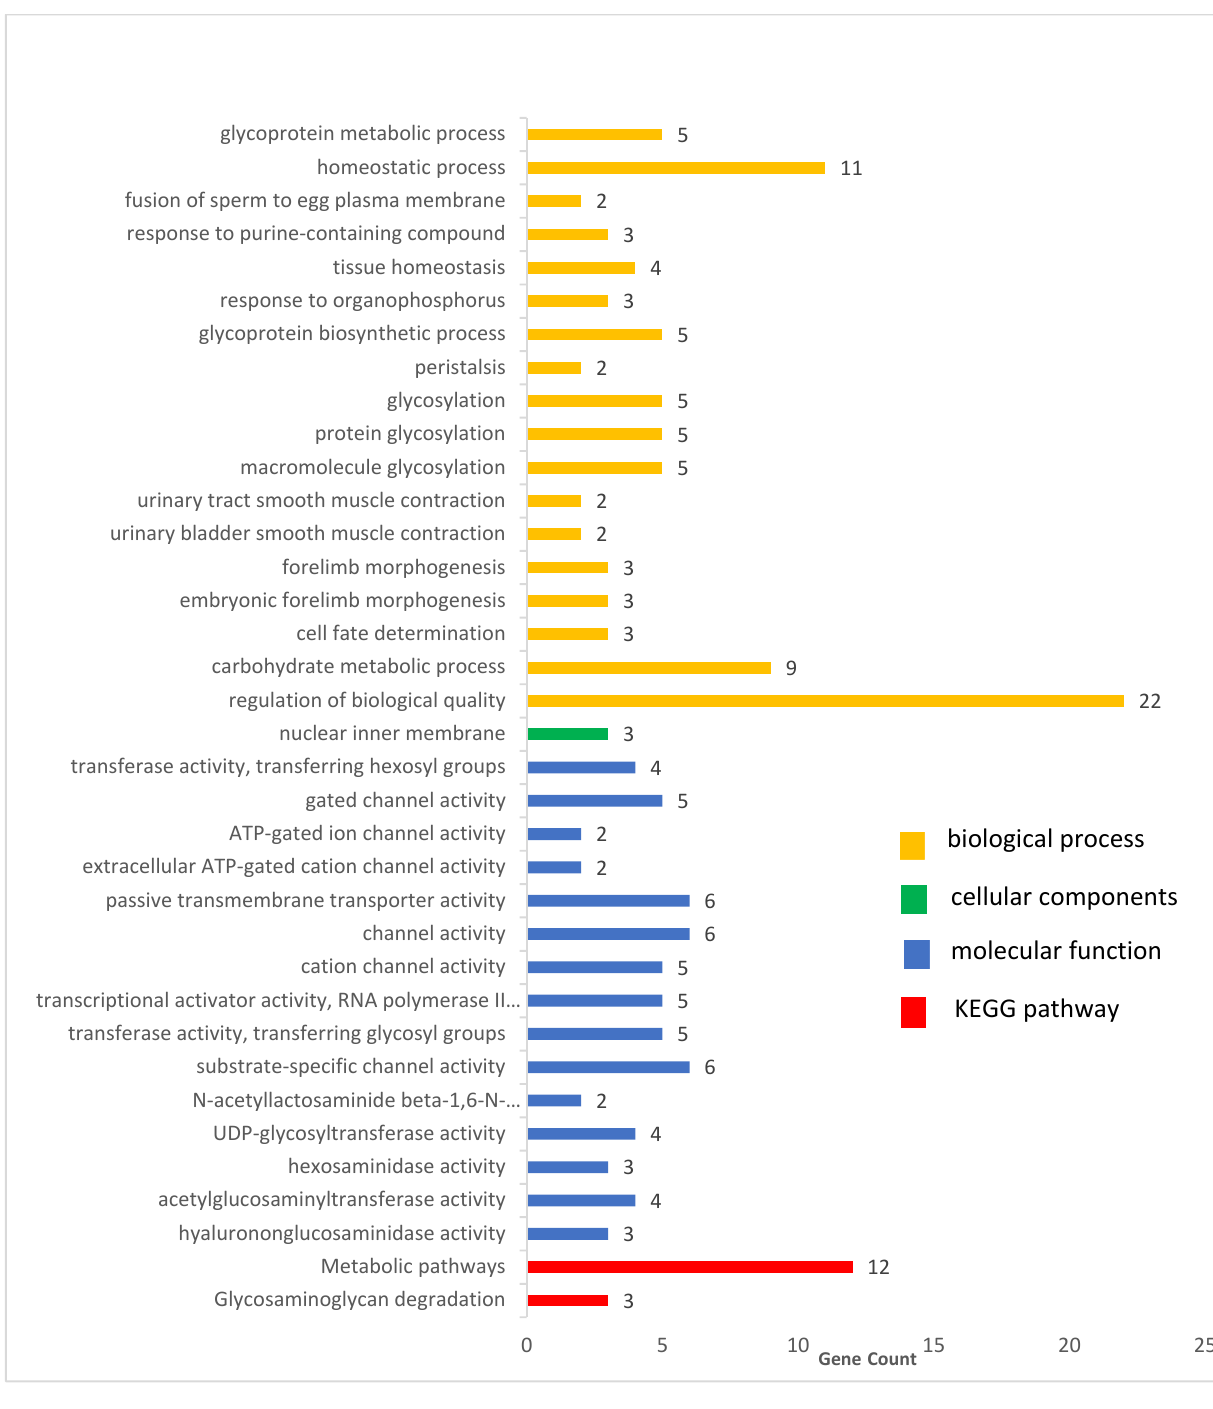
Figure 5. Significant GO terms (biological process, cellular component and molecular function) and KEGG pathways of candidate genes related to feet and leg traits.